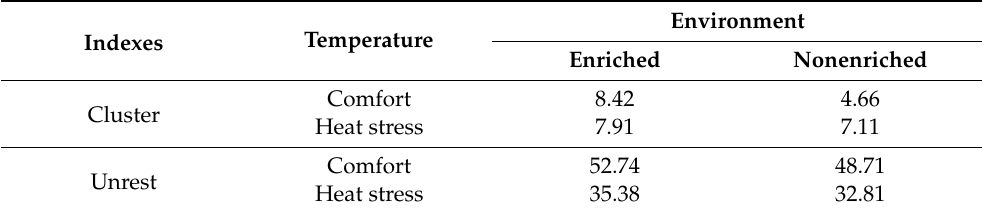
Table 1. Results of the Tukey test ( p < 0.05) for the cluster and unrest indexes in the combined conditions of temperature and environmental enrichment found in the proof-of-concept